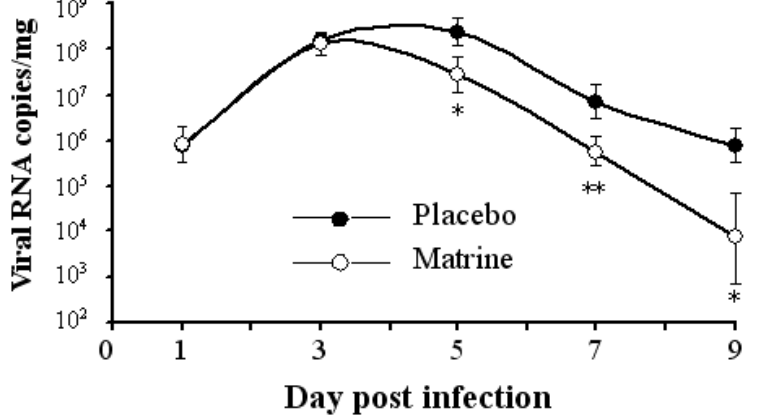
Figure 5. Matrine treatment inhibited the replication of EV71 in muscle tissues of mice (n = 40). The infected mice were treated with the placebo or matrine at a dose of 20 mg/kg. The muscle tissues were sampled and subjected to viral RNA copy analysis by qRT-PCR at 1, 3, 5, 7 and 9 dpi. The data are expressed as the mean values of three independent experiments (*: p < 0.05, **: p <